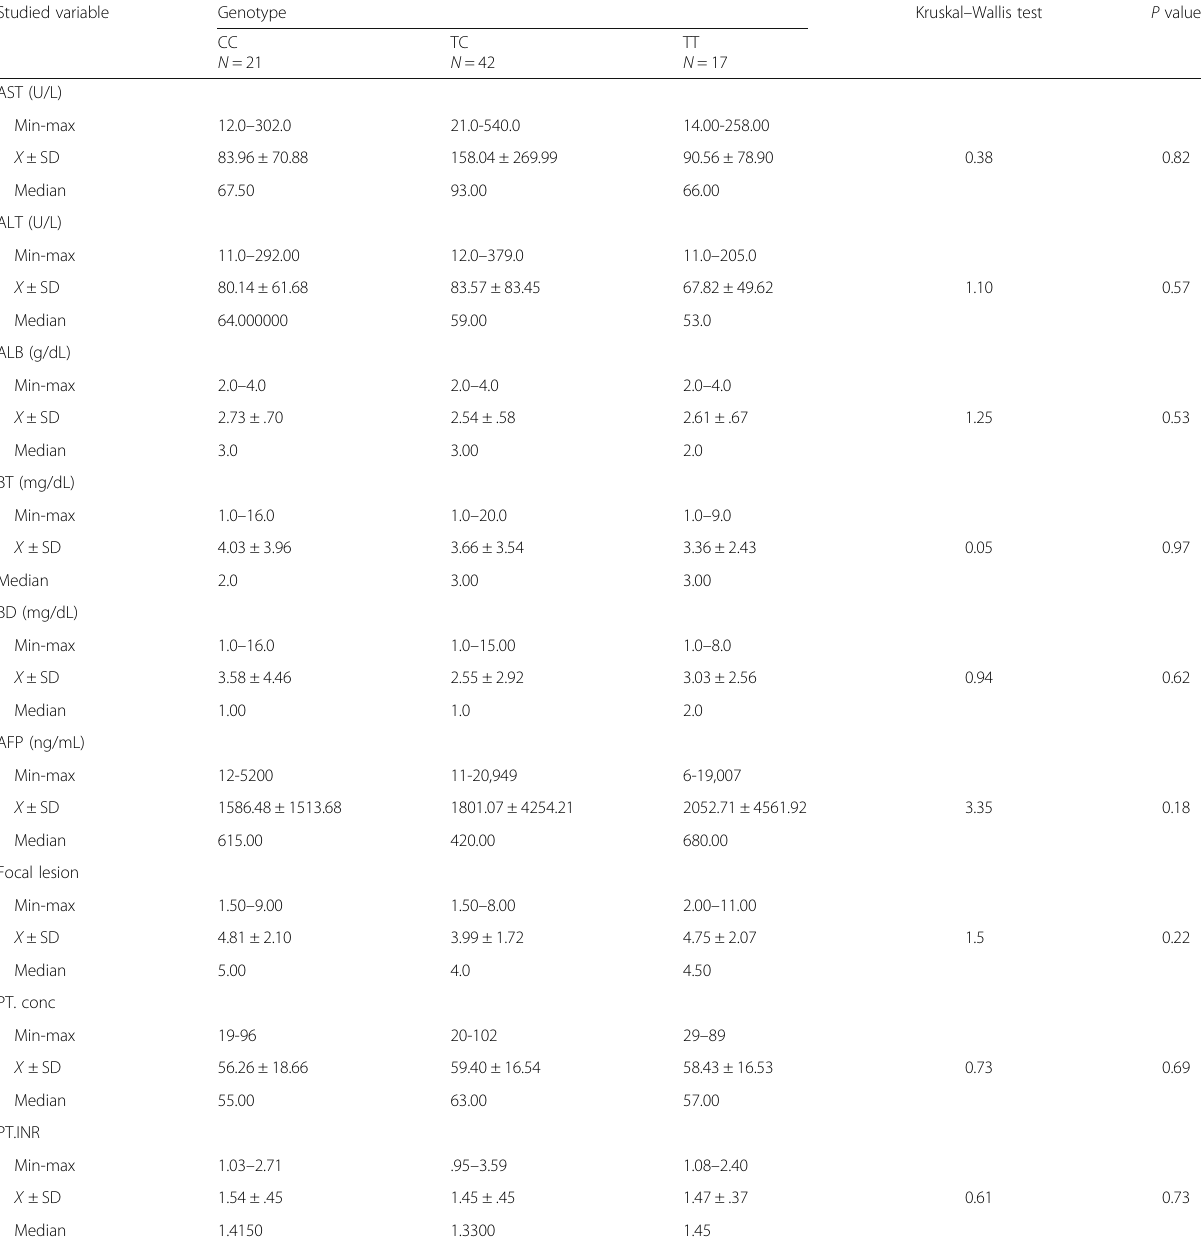
Table 7 Relation between genotypes and clinicopathological data among HCC patients Studied variable Genotype Kruskal – Wallis